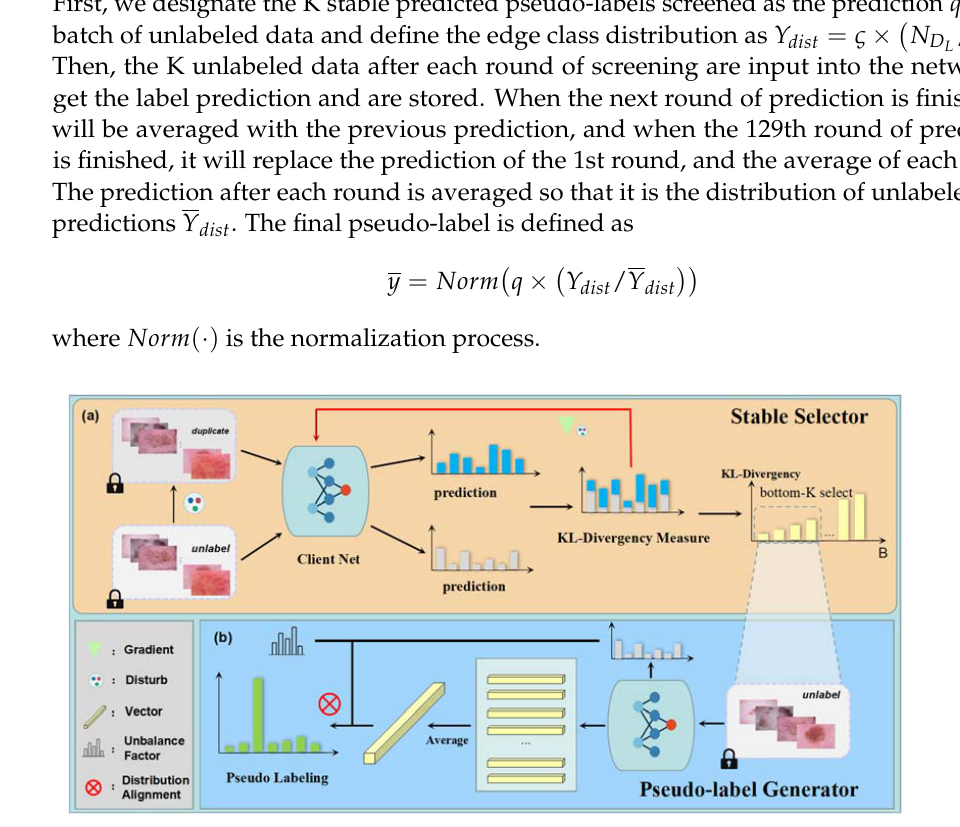
Figure 5. The pseudo-label construction method consists of two parts: ( a ) Data stability selector, which selects the optimal data by measuring the difference of data distribution in different states of the same picture. ( b ) Pseudo-label generator, which combines the probability distribution and dis- tribution alignment generated by the screened pictures into the network to generate label predic- tions.